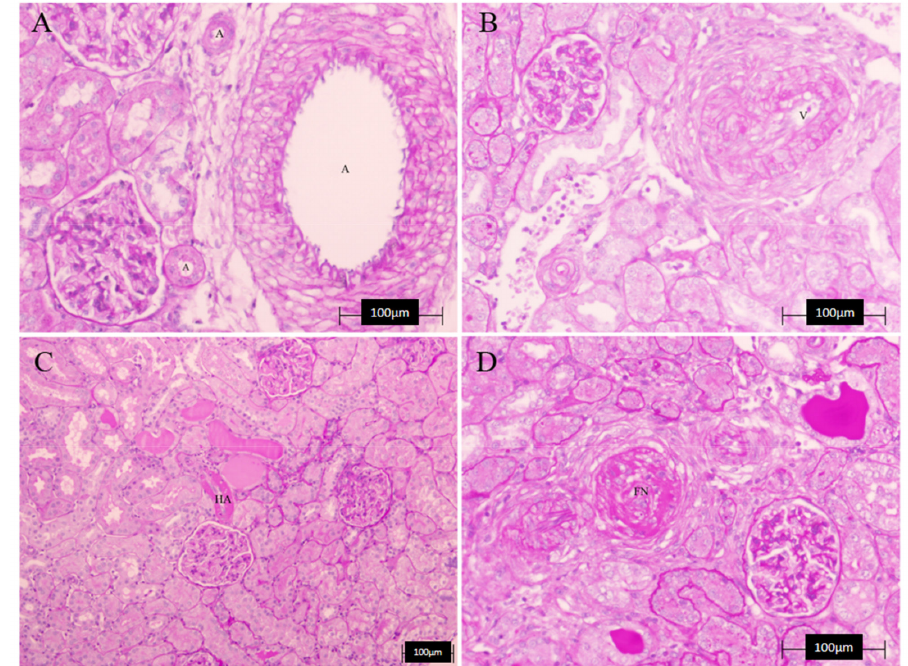
Figure 7. Representative microphotographs of kidney lesions. ( A ) renal artery ( A ) of a control non-treated rat (no morphological alterations, PAS, 20 × ); ( B ) muscular hypertrophy and lumen reduction in a renal artery (V) of L-NAME-treated rat (PAS, 20 × ); ( C ) hyaline arteriopathy (HA) and lumen reduction in a renal artery of L-NAME-treated rat (PAS, 10 × ); ( D ) fibrinoid necrosis (FN) in a renal artery of L-NAME-treated rat (PAS, 20 ×